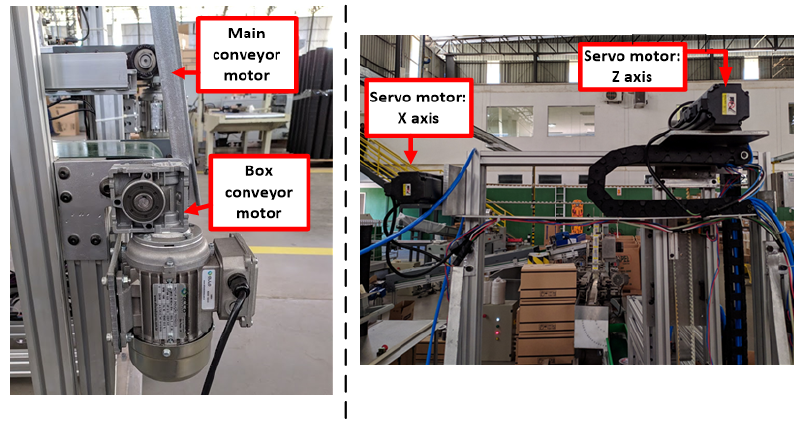
Figure 7. Installation of three-phase motor and servo-motors.